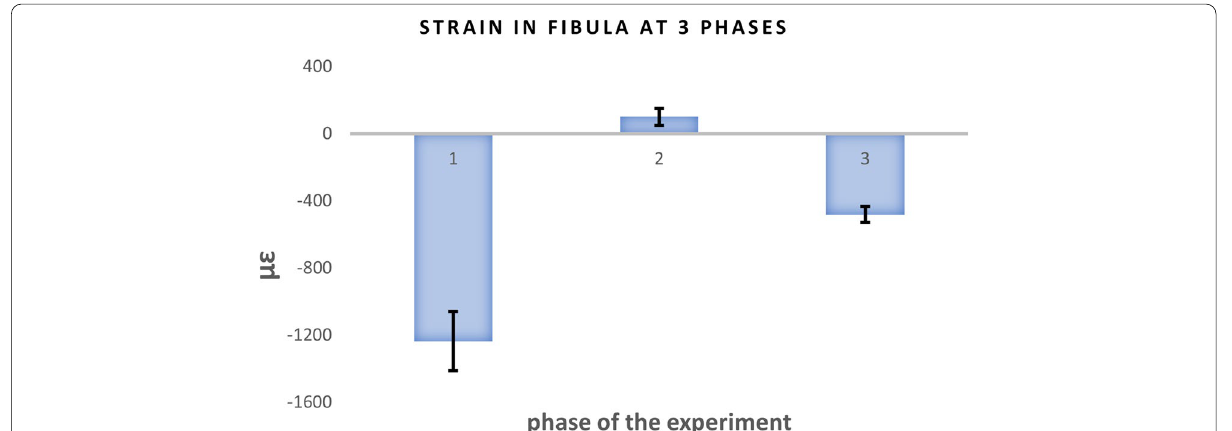
Fig. 4 Graph of fibular strain in the three phases of the procedure. Standard error is 86.8μ ɛ ; p < 0.001